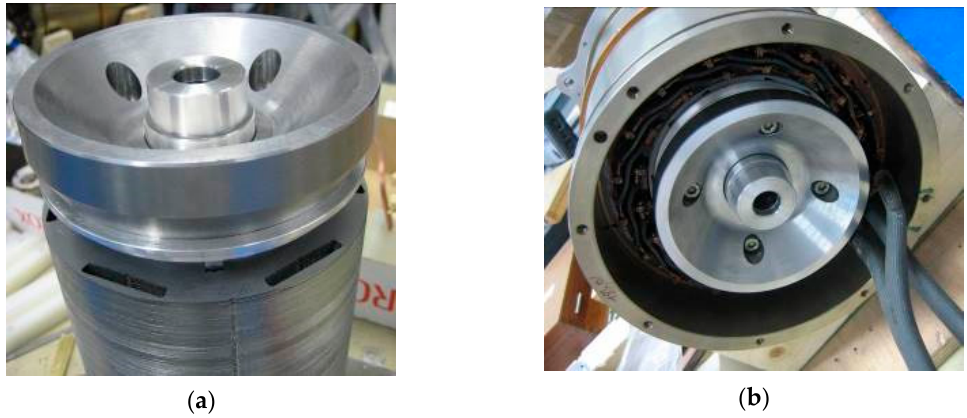
Figure 15. Machine during assembling. ( a ) Rotor assembling; ( b ) machine assembling.